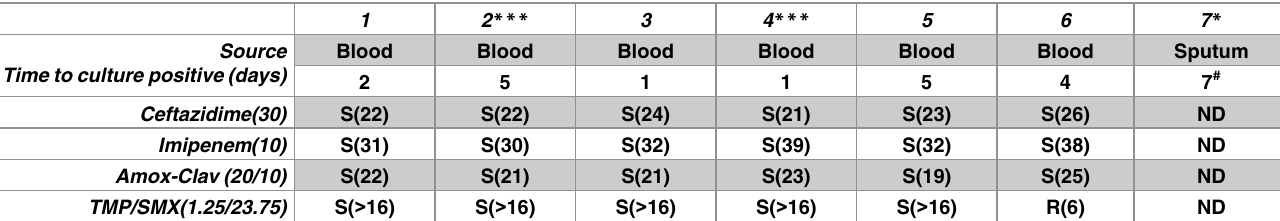
Table 2. Clinical isolate